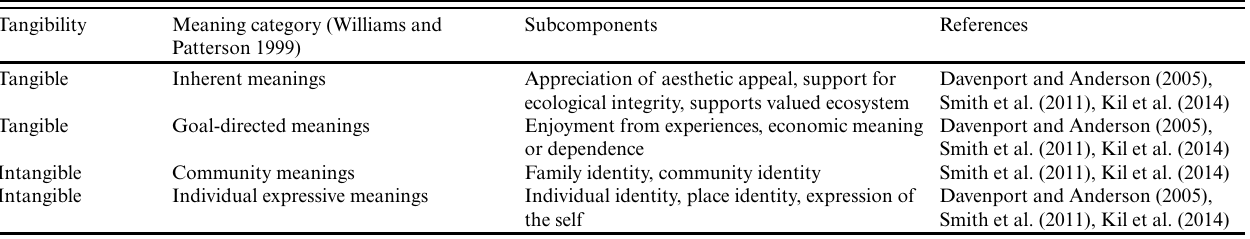
Table 1. Summary of tangible and intangible place meanings and their associated